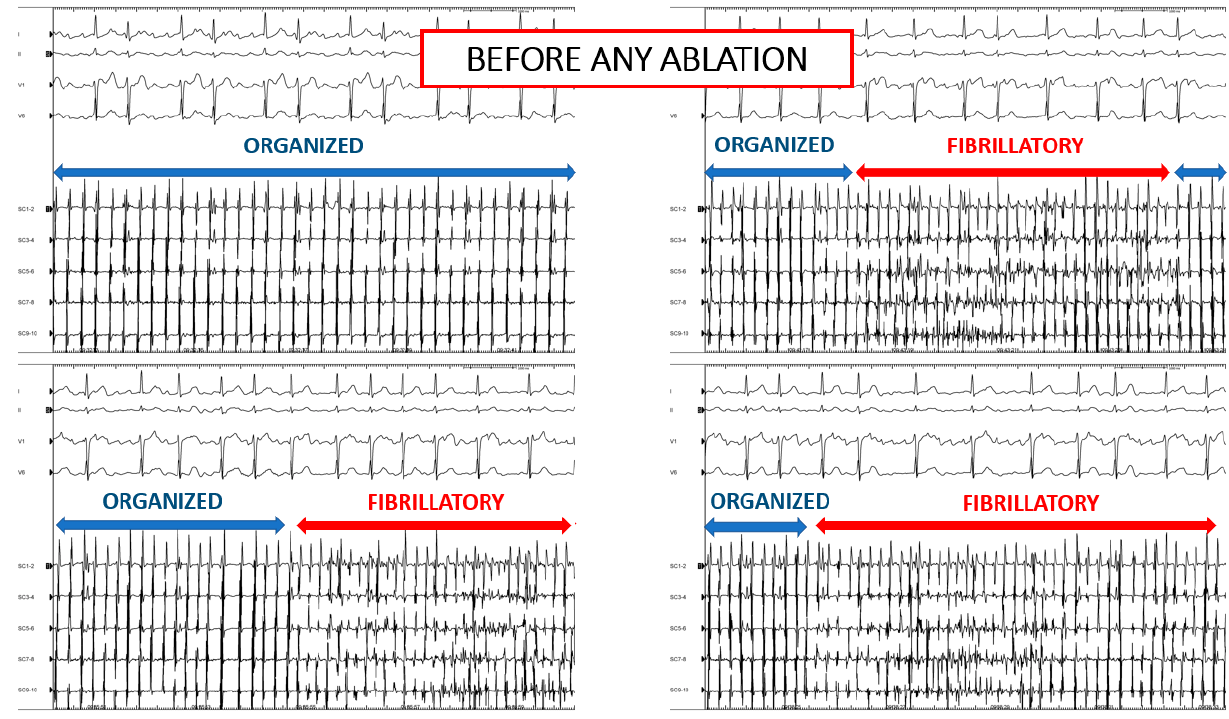
Figure 6. Coronary sinus EGMs showing subsequent AF and AT in a patient prior to any ablation.